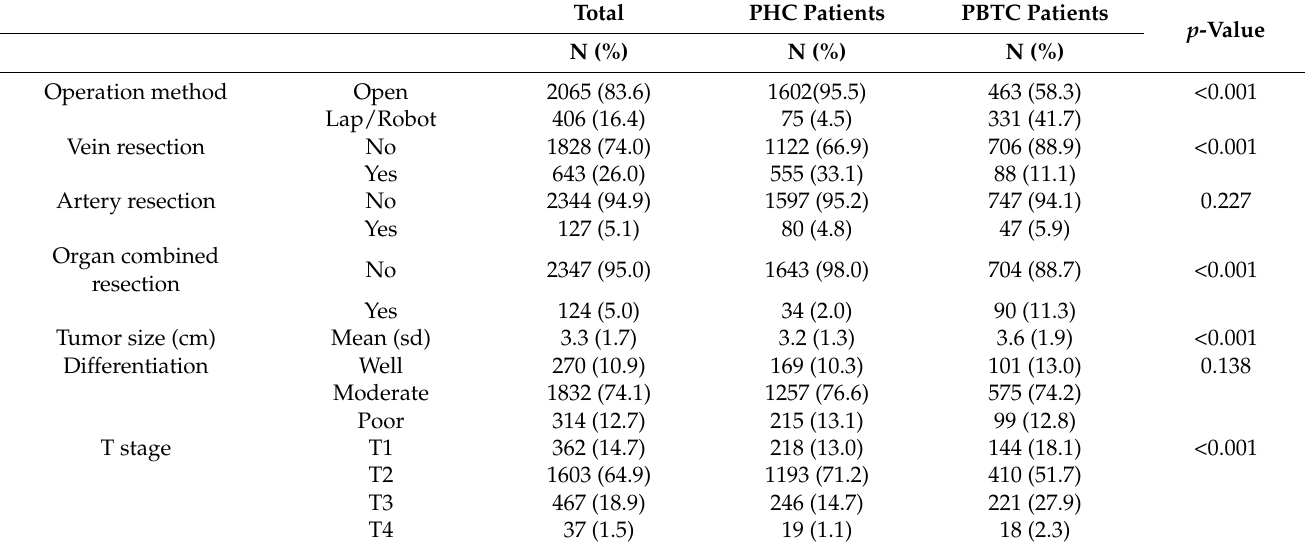
Table 2. Comparison of surgical and pathological characteristics of all pancreatic ductal adenocarcinoma patients.